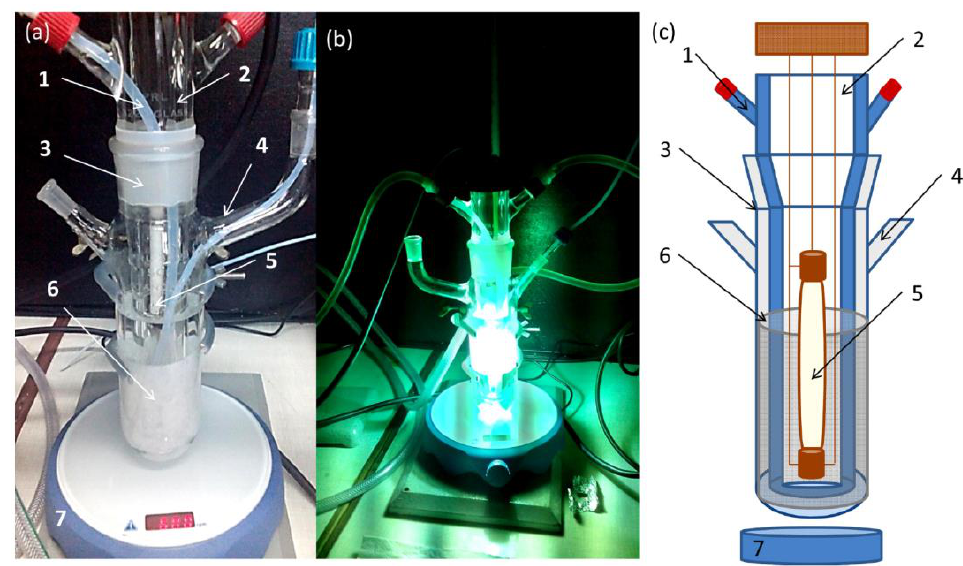
Figure 7. Photocatalytic system. ( a ) Before the reaction, ( b ) during the reaction, and ( c ) schematic representation. (1) lamp cooling system (2) double-walled immersion well (3) photoreactor (4) port for taking samples (5) 125 W UV lamp (6) photocatalyst (7) magnetic stirrer. (Reprinted with per- mission from Ref. [50]. © . Elsevier 2015).